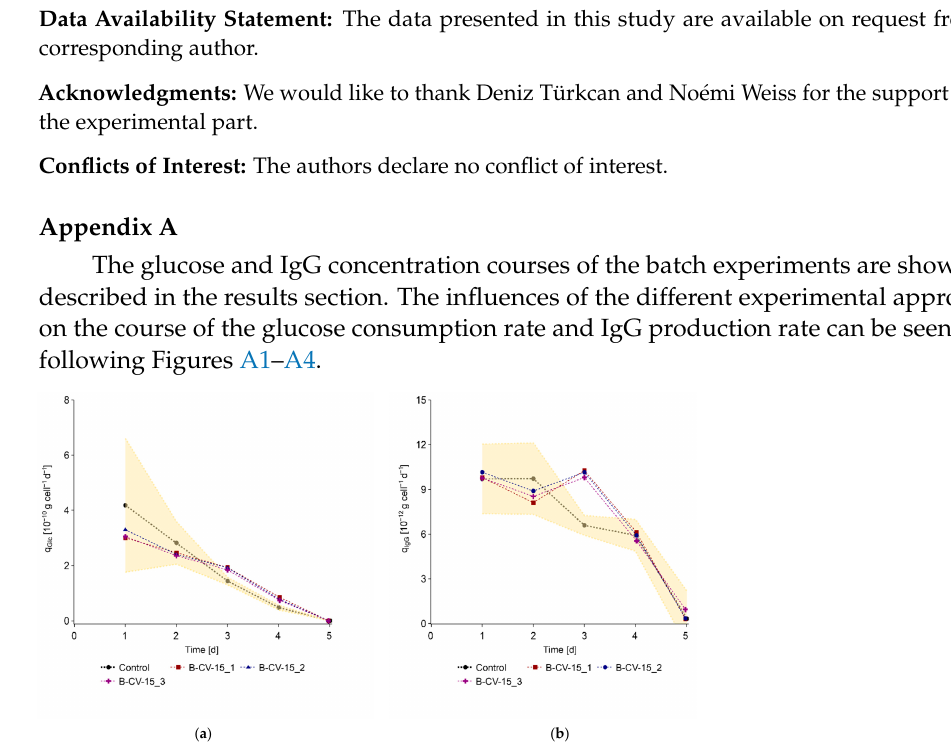
Figure A1. Course of ( a ) glucose consumption rate, and ( b ) IgG production rate during the batch experiments inoculated directly from cryovials (nomenclature: B = Batch, CV = inoculated out of cryovial, 15 = VCD in cryovial ( × 10 6 cells mL − 1 )). Control: batch experiments with standard inoculum production ( n = 3).